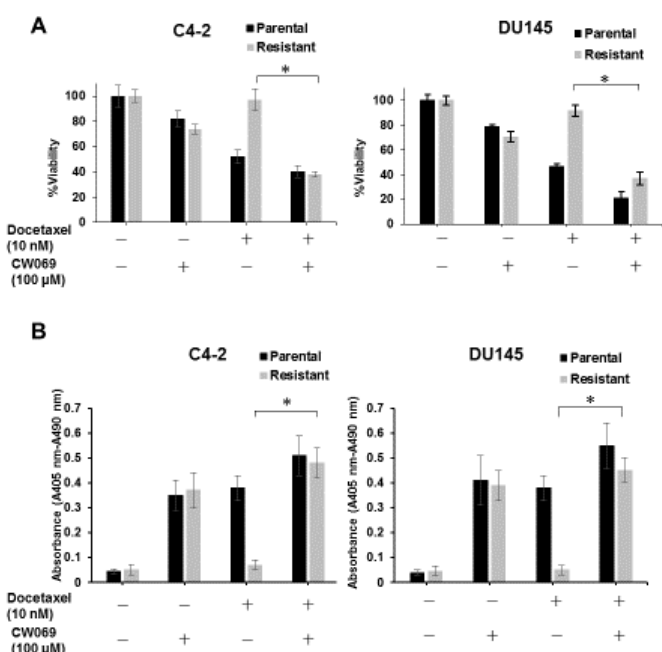
Figure 5. CW069 re-sensitizes DTX-resistant cell lines to docetaxel (DTX) treatment. ( A ) The effect of the combination of DTX and CW069 on cell viability in parental and DTX-resistant cell lines in DU145 and C4-2 cells. The results are expressed as the mean and S.D. of triplicate measurements. * p < 0.01. ( B ) The effect of the combination of DTX and CW069 on apoptosis in parental and DTX-resistant cell lines in DU145 and C4-2 cells. The results are expressed as the mean and S.D. of triplicate measurements. * p < 0.01. Table 1. The combination index (CI) values for the combination of docetaxel (DTX) and CW069 in DTX-resistant cell lines.